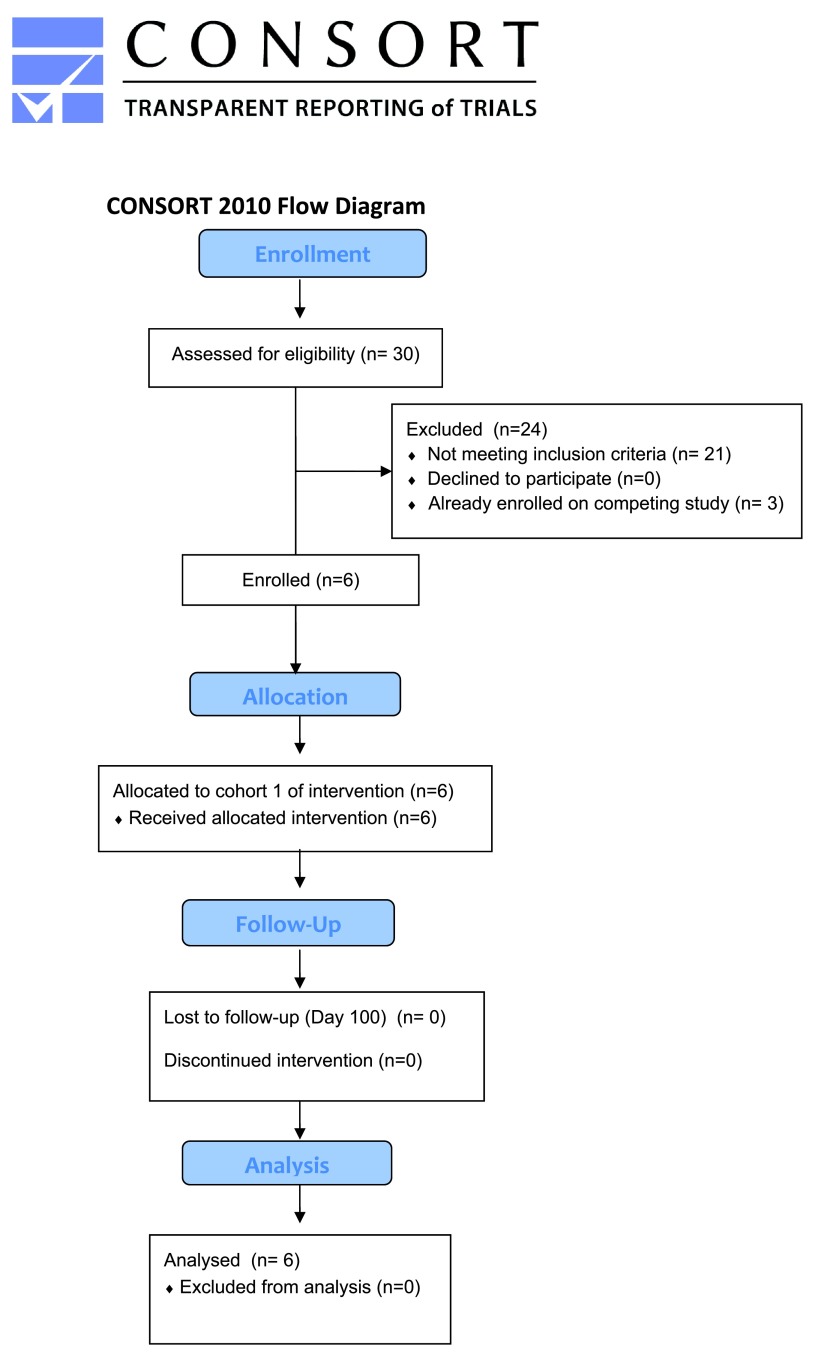
Clinical trial participant flow diagram (CONSORT).Recruitment, enrollment and subsequent flow through the study for the clinical trial cohort (n=6) is shown.